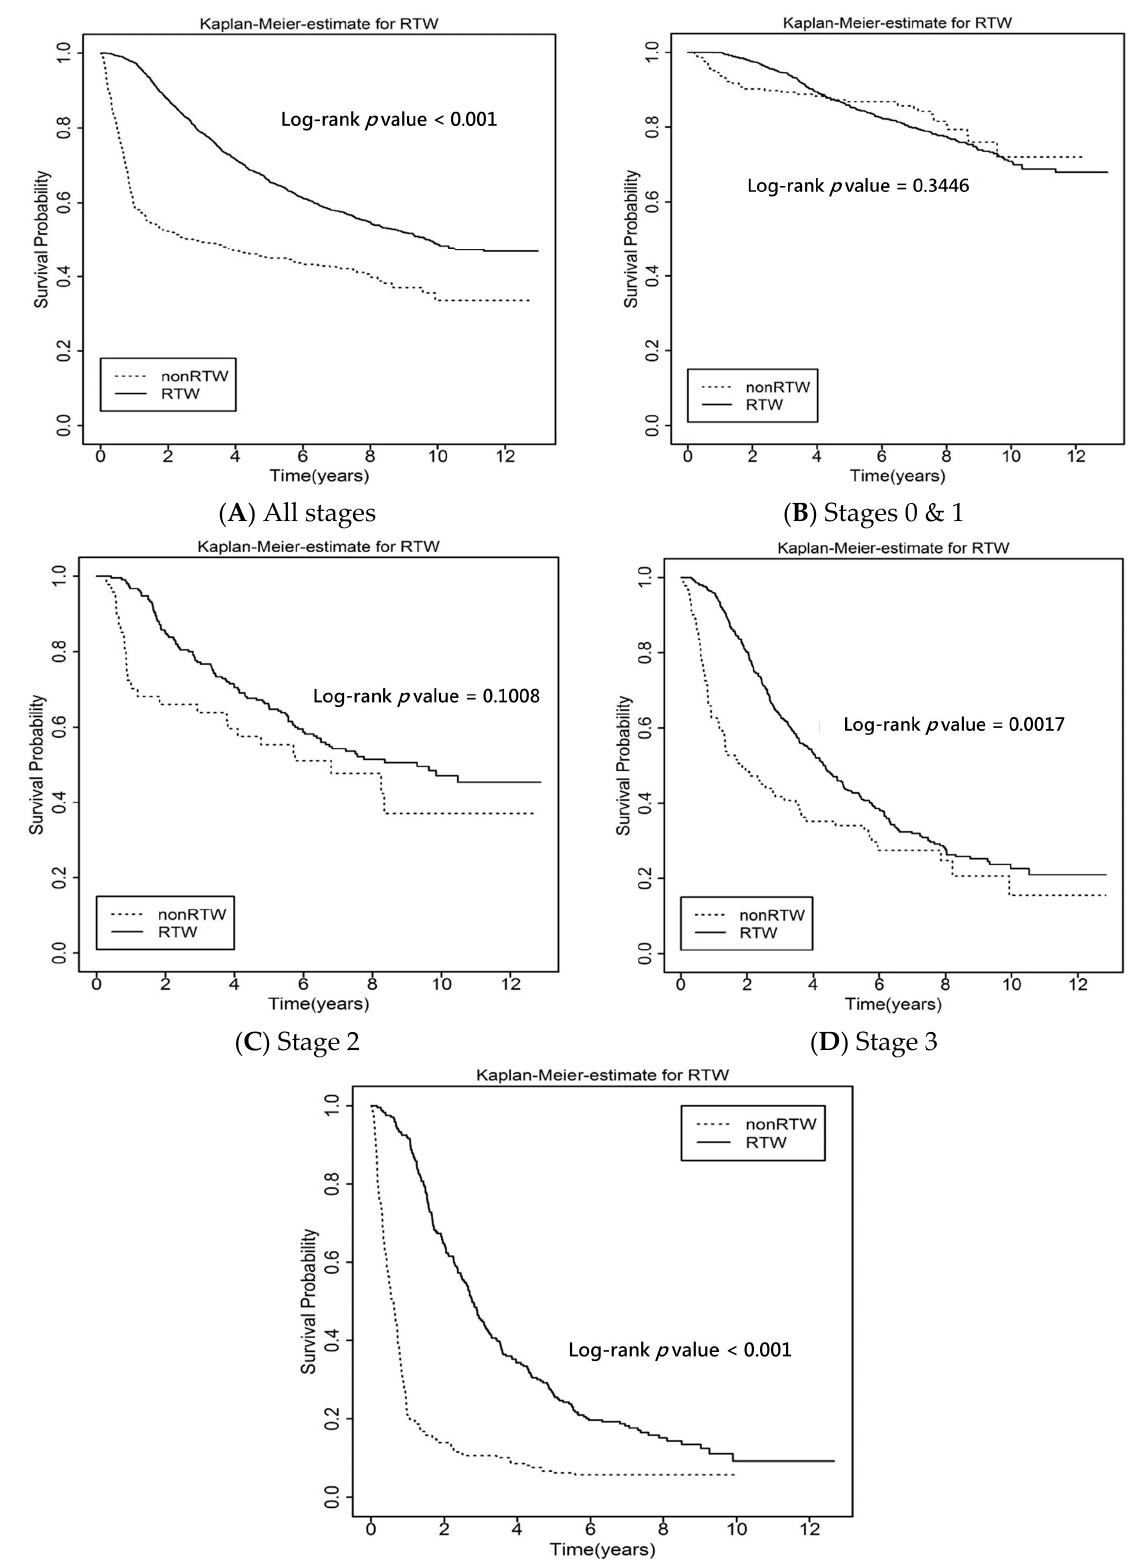
Figure 4. Kaplan–Meier (KM) curves showed survival probability of RTW for ( A ) all, ( B ) stages 0 and 1 and ( C – E ) stages 2–4 lung cancer survivors.